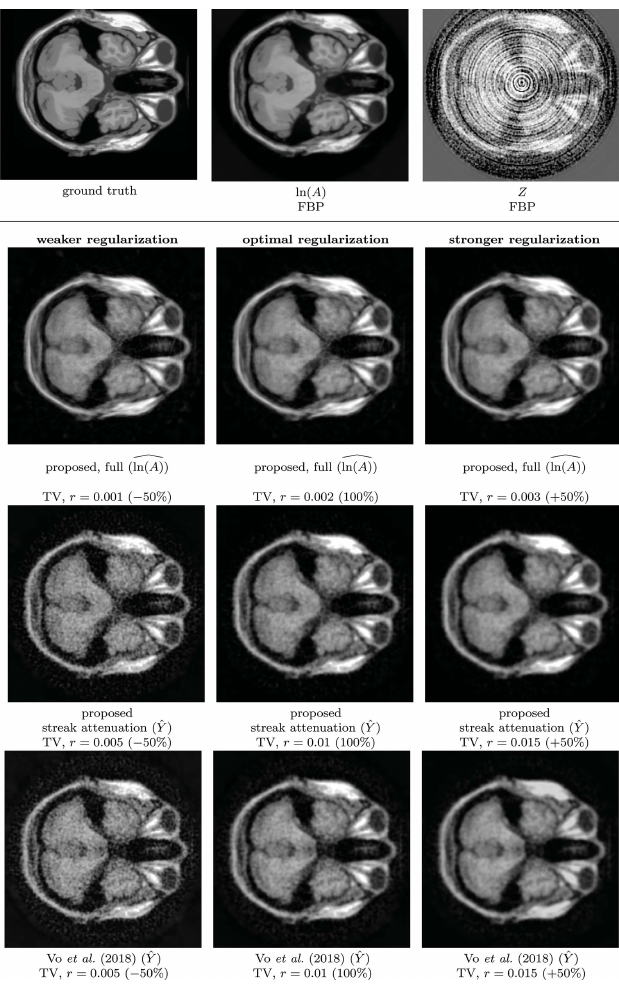
Figure 5 Comparison of reconstructions of the 3-D BrainWeb phantom corrupted with streak and Poisson noise as in (3), corresponding to the sinograms shown in Fig. 4. Top: ground truth volume, and reconstructions of ln( A ) (3) and Z (4) obtained through filtered back-projection. Bottom: comparison of TV reconstruction of estimates with various regularization strengths r , where the percentage implies a multiplier to the regulariza- tion optimized to maximize SNR, i.e. 100% means ‘SNR-optimal’ regularization. Top-to-bottom: proposed full estimate ln( A ), proposed streak-free estimate ^ YY , and streak-free estimate of ^ YY (Vo et al. , 2018), each with 100%, 50%, and 150% relative regularization strengths. Proposed estimates are computed embedding the improved BM4D. Notably, the full filtering offers improved reconstruction quality, and is also less sensitive to variations in the regularization parameters.